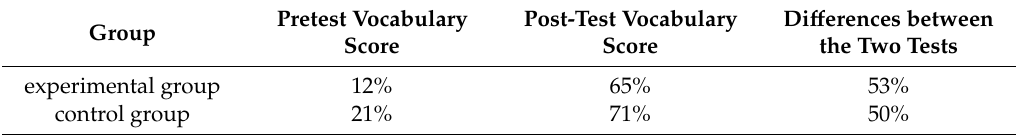
Table 2. A comparison of the two vocabulary test scores between the experimental group and the control group. Group